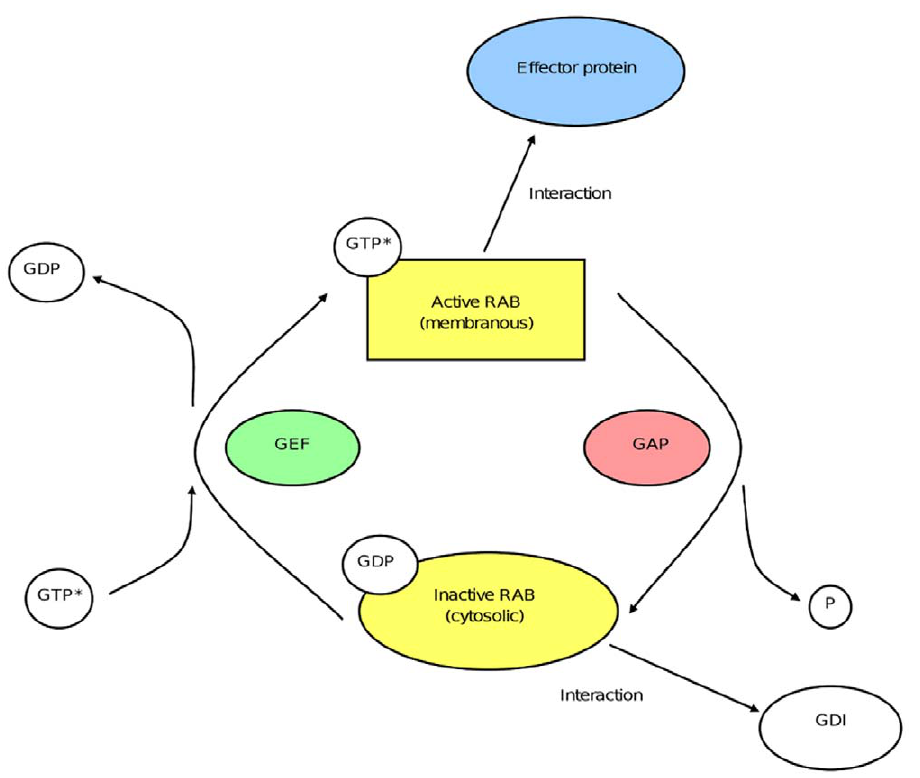
Figure 4. Rab and Rab-interacting proteins. Example of the Rab27 cluster. The Rab27 cluster is comprised of the two RAB27 isoforms ( RAB27A and RAB27B ), the GEF MADD , the GAP TBC1D10A and 12 effector proteins. The other Rab and Rab-interacting proteins are shown in supplementary Figure S1.